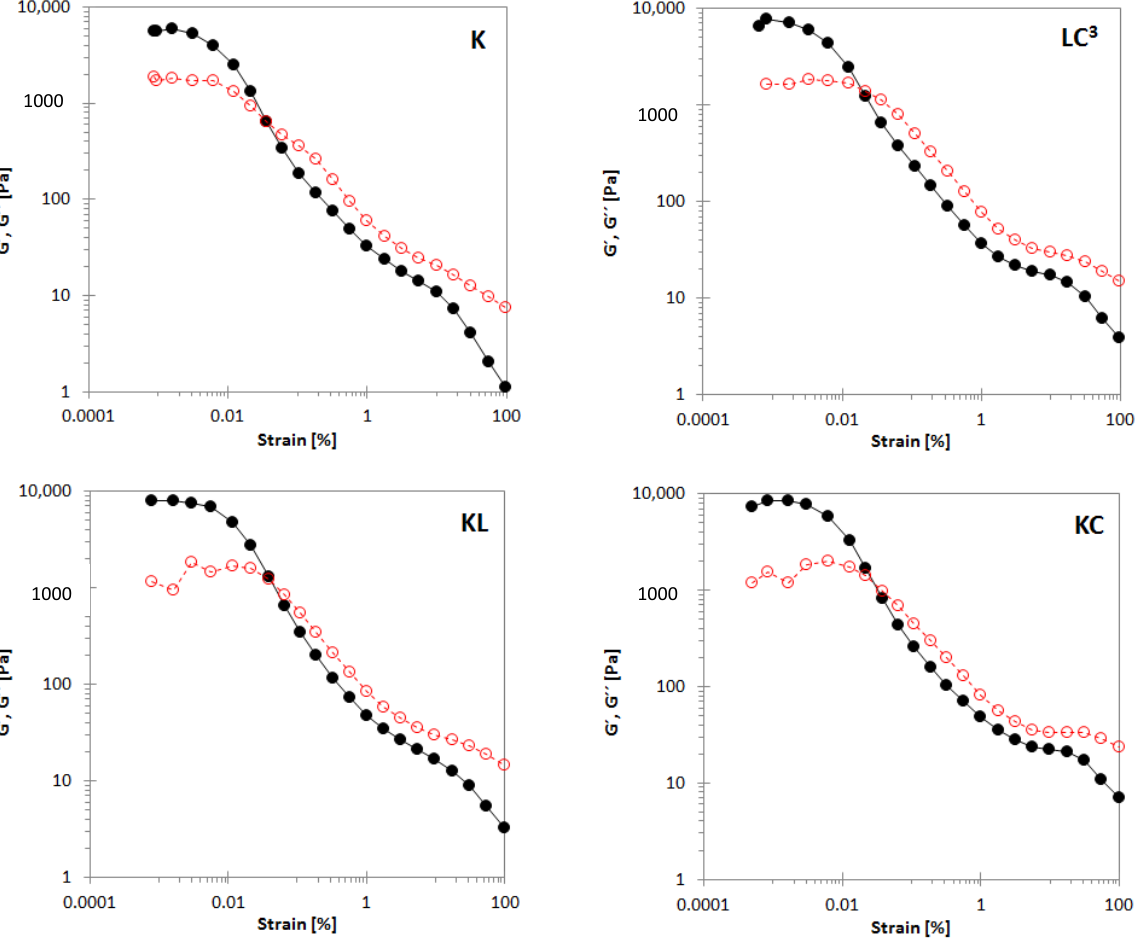
Figure 5. Elastic modulus G′ (filled circles) and viscous modulus G′′ (open circles) vs. oscillation strain amplitude γ for all samples at an early age (0 min).